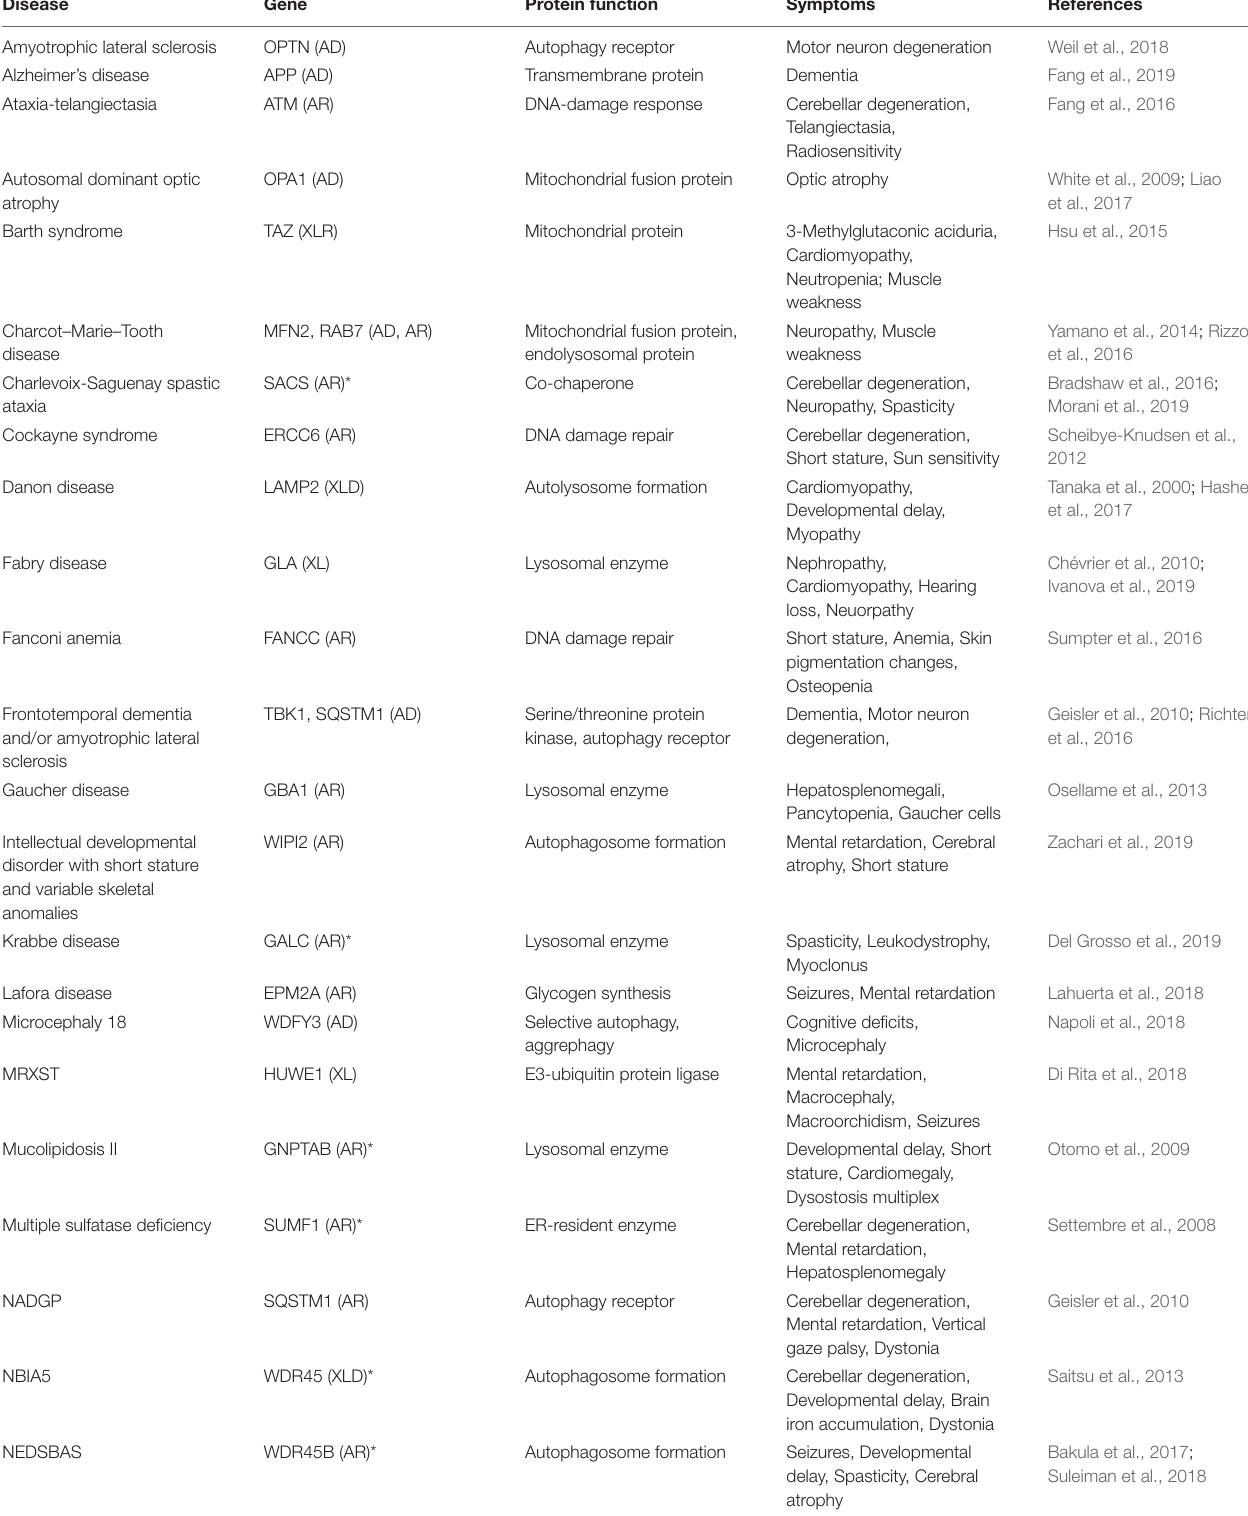
TABLE 1 | Examples of autophagy/mitophagy-related monogenic